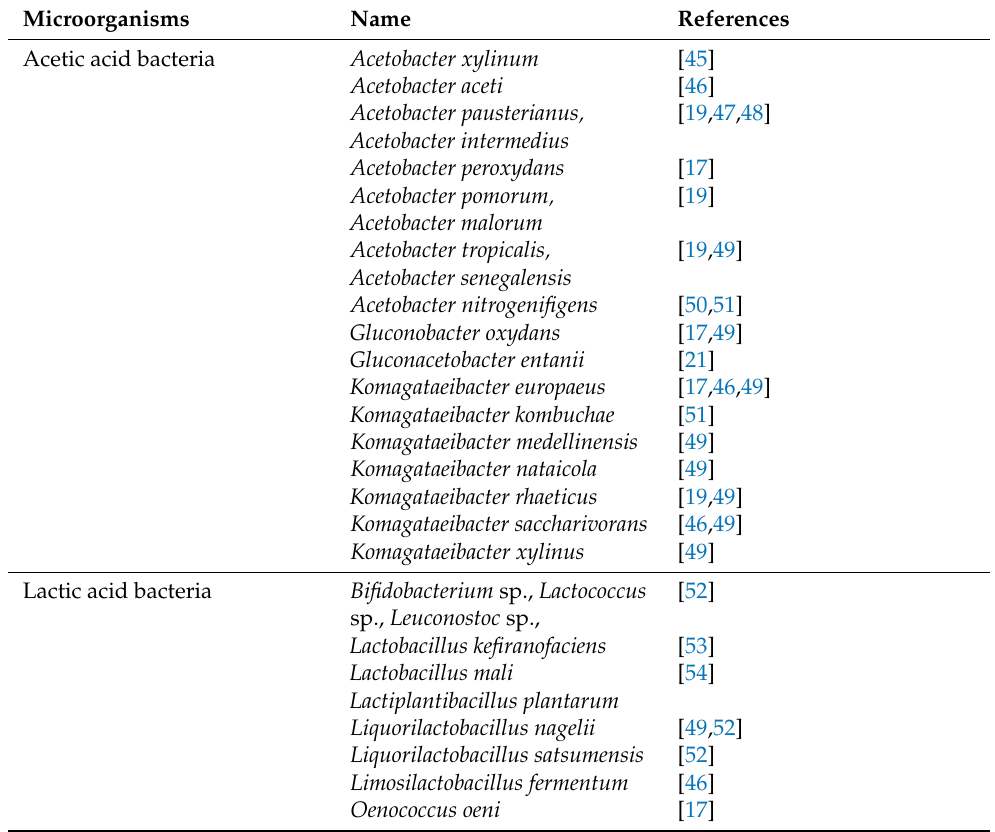
Table 1. Microbial species mainly found in SCOBY for kombucha fermentation.